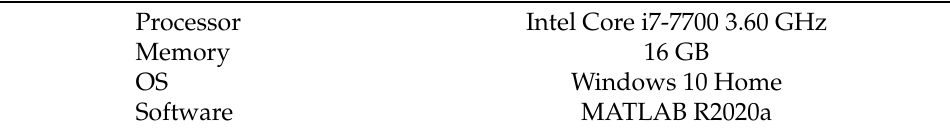
Table 4. Machine specs used for evaluating runtime.